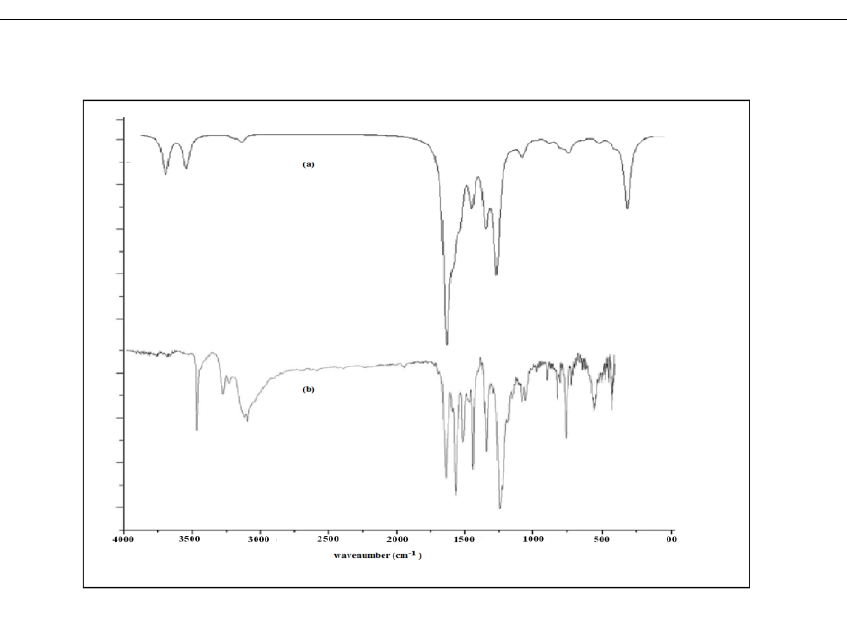
Figure 2 . FT-IR spectrum of ANP (a) computed with B3LYP/6-31++G(d, p) (b)